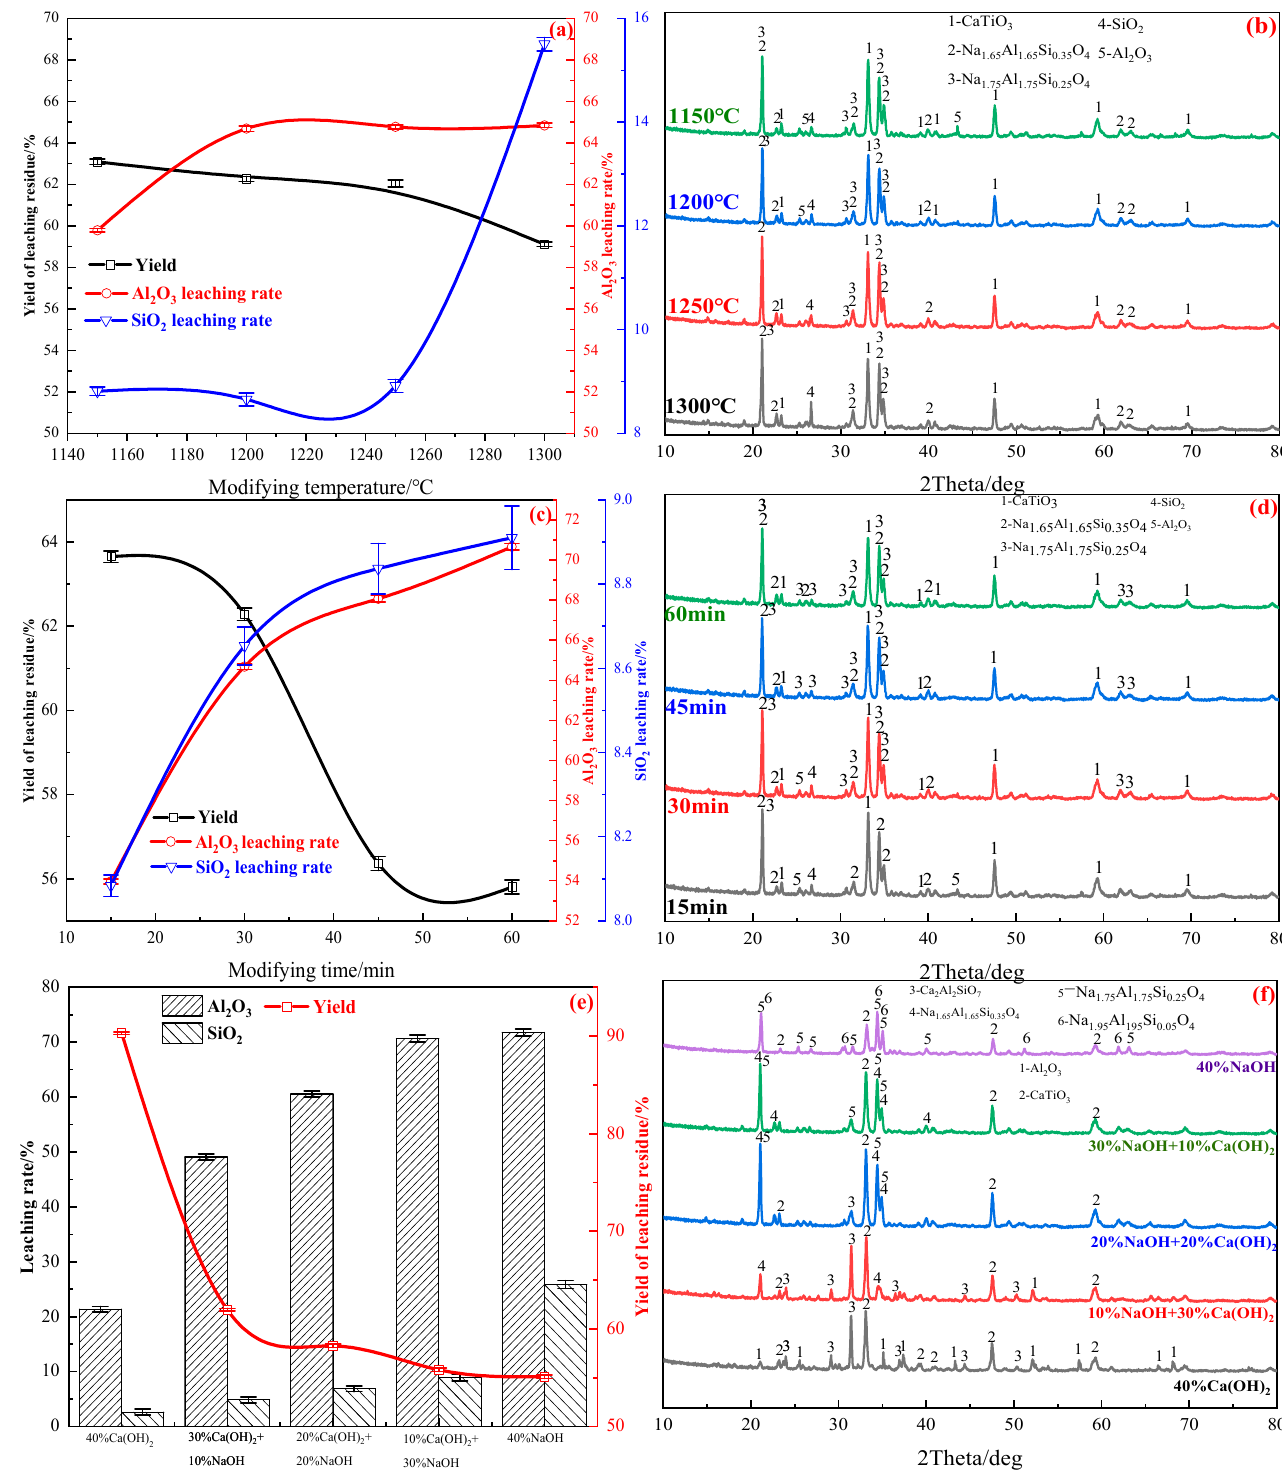
Figure 5. Effect of roasting parameters on the extraction of Al 2 O 3 and mineral compositions (( a , c , e ): extraction of Al 2 O 3 , ( b , d , f ): mineral composition). (( a ): 30% NaOH + 10%Ca(OH) 2 , modifying duration of 30 min; ( c ): 30% NaOH + 10% Ca(OH)2, modifying at 1200 °C; ( e ): modifying at 1200 °C for 60 min).